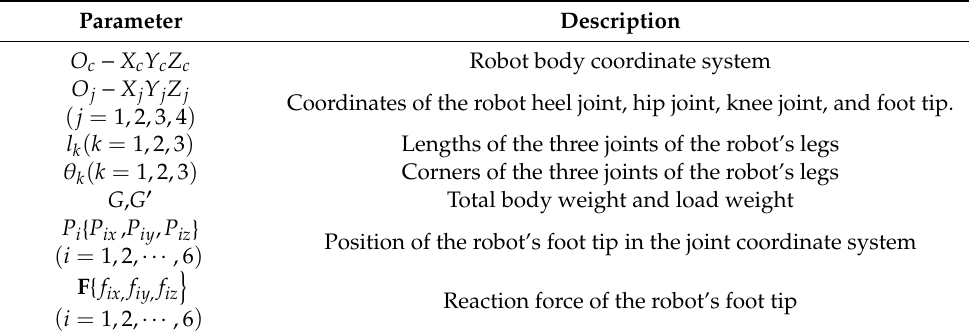
Table 2. MDH parameters of the right-middle